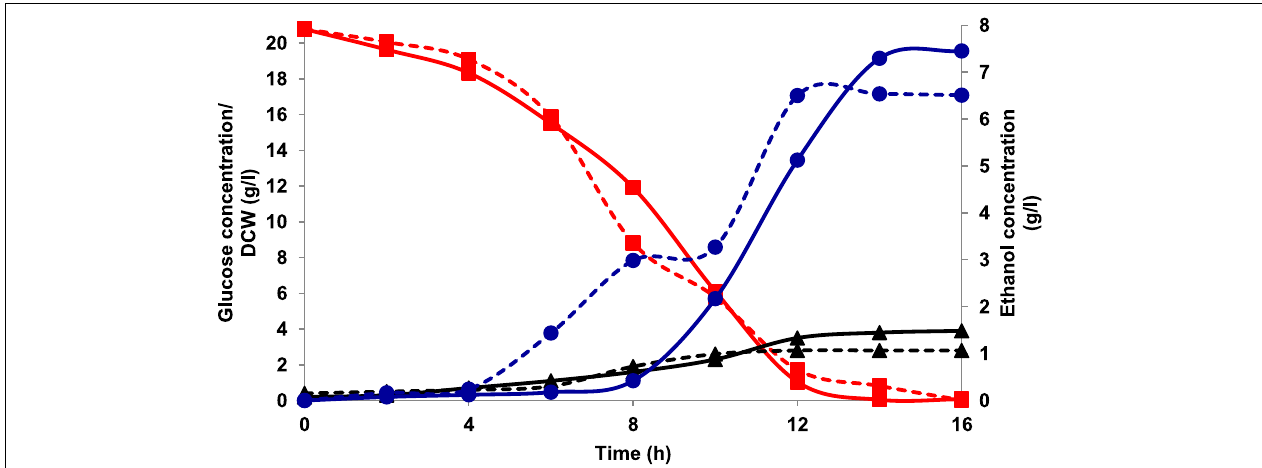
FIGURE 1 | Growth of K. marxianus NIRE-K1 and NIRE-K3 in YEPD medium, (---) K. marxianus NIRE-K1; (—) K. marxianus NIRE-K3; ( (cid:4) ) Glucose; ( N ) Dry cell weight (DCW); ( • ) Ethanol.